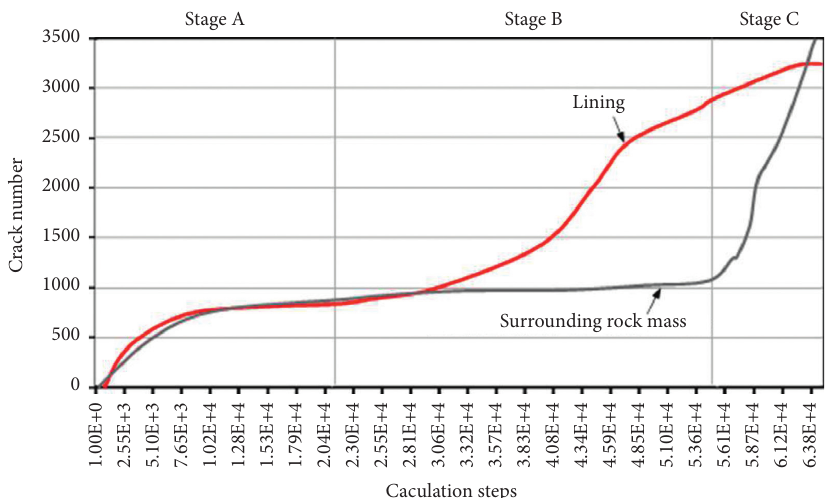
Figure 15: The evolution of crack number during strong-stiffness rockburst